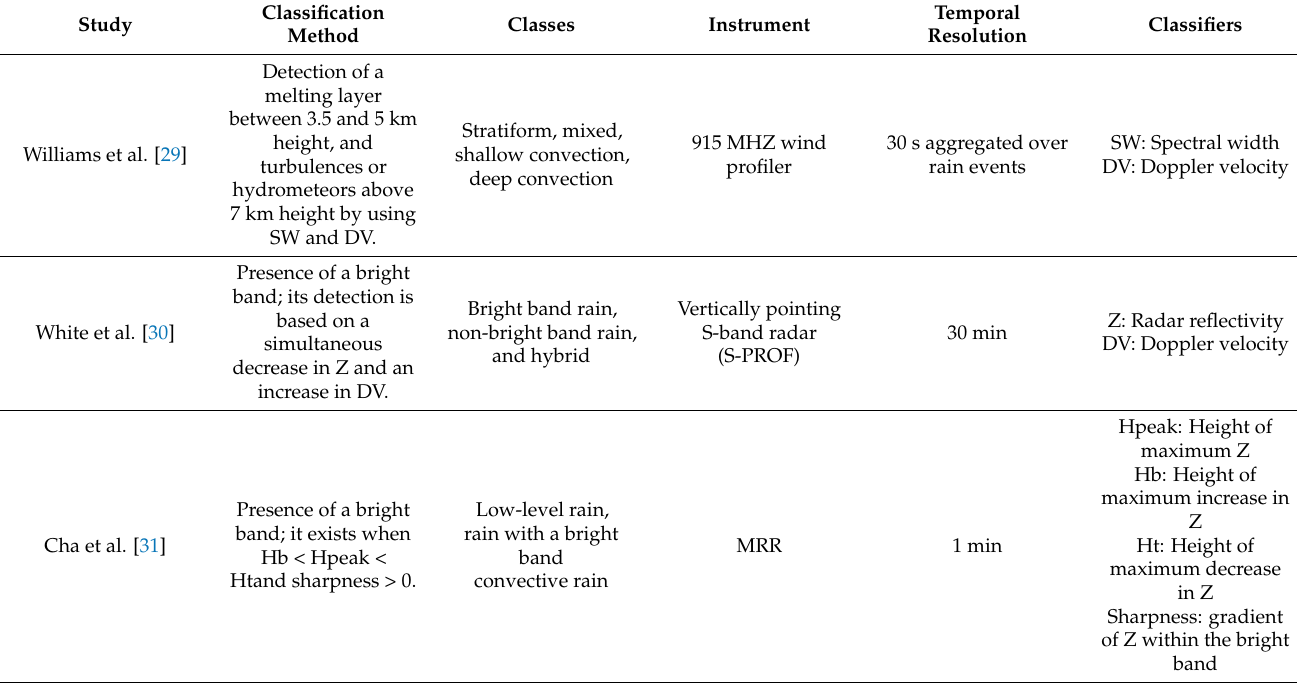
Table 1. Rain regime classification methods considering vertically pointing radars or